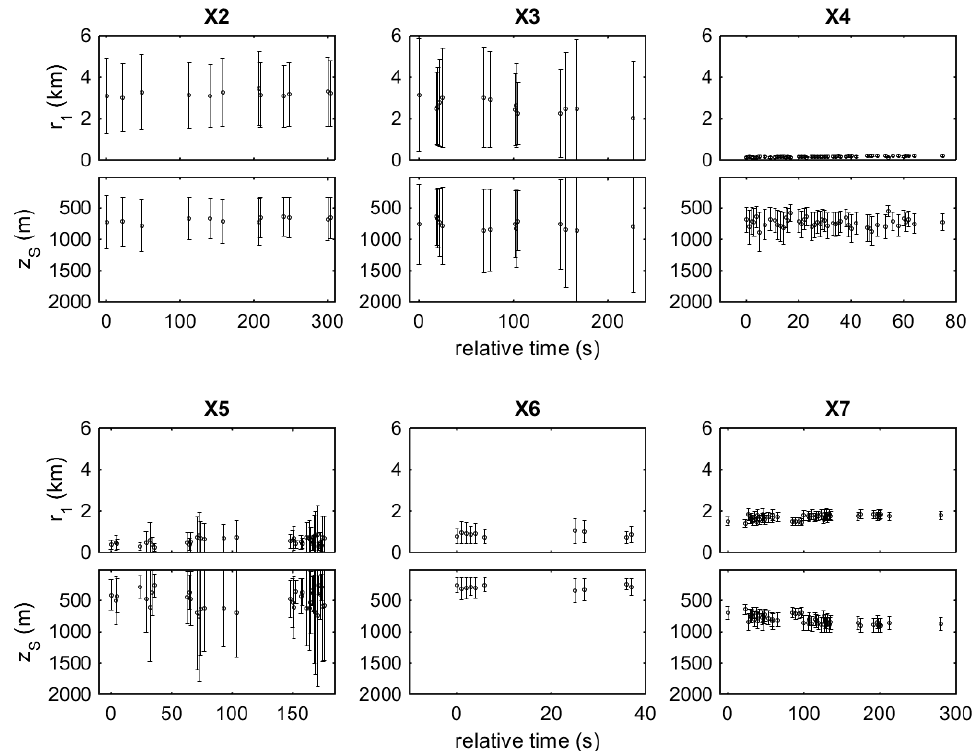
Figure 15. Localization results for source range (from front hydrophone) and depth for sperm whale X during stations X2–X7. The error bars about the estimated means ( ◦ ) indicate the posterior RMS errors.